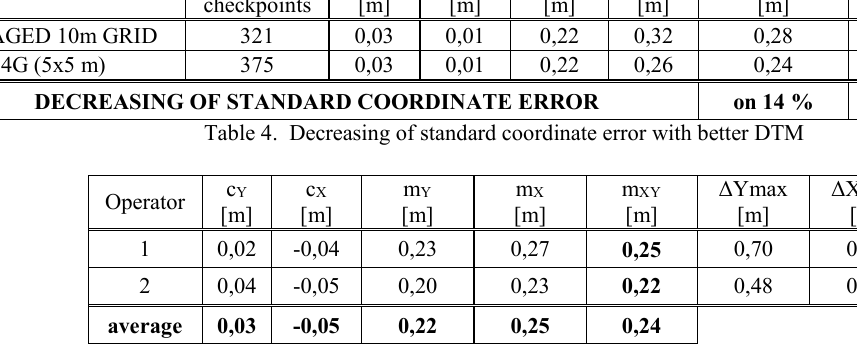
Table 5. Testing of absolute position accuracy of the Orthophoto of the